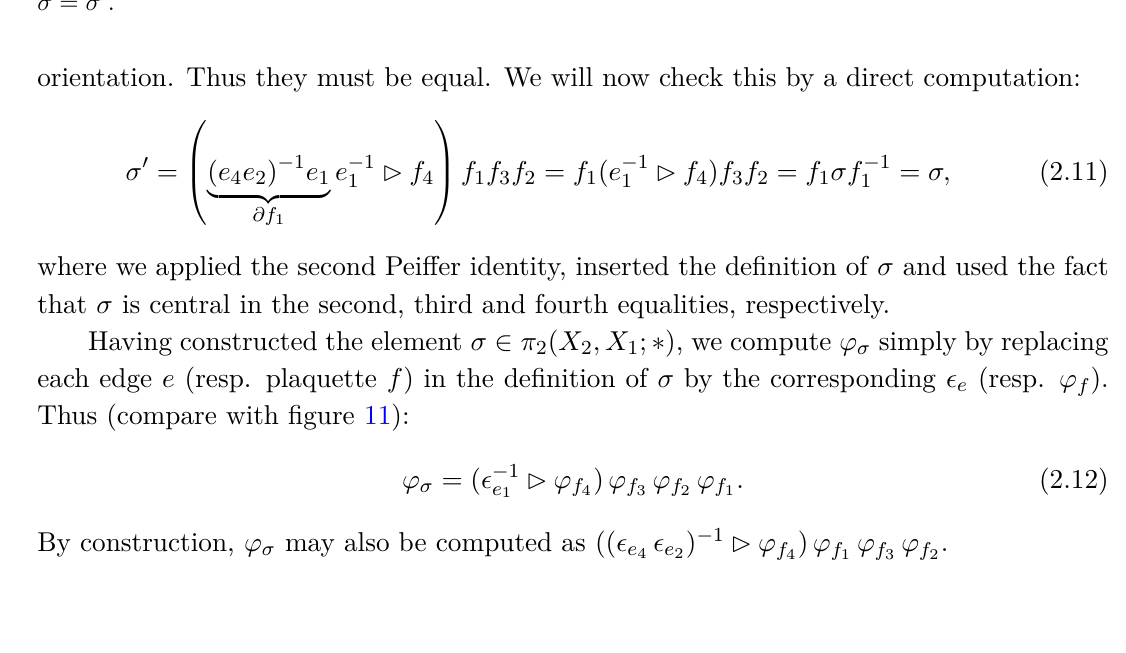
B f ) f and σ 0 = (( e ) − 1 B f ) f . In fact we have 4 3 f 2 f 1 4 e 2 4 1 f 3 f 2 1